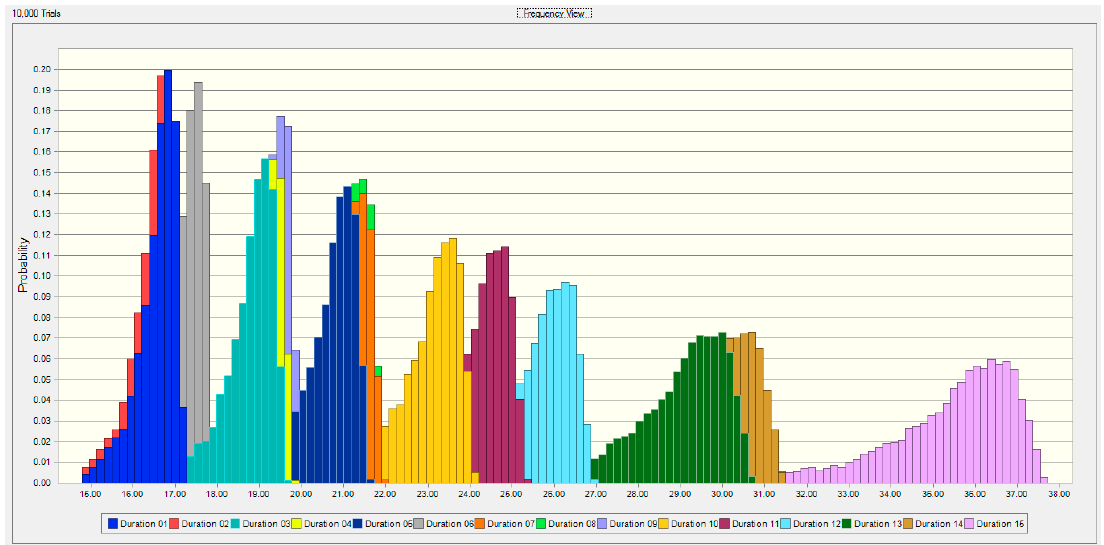
Figure 3. Overlay charts of Duration distributions.